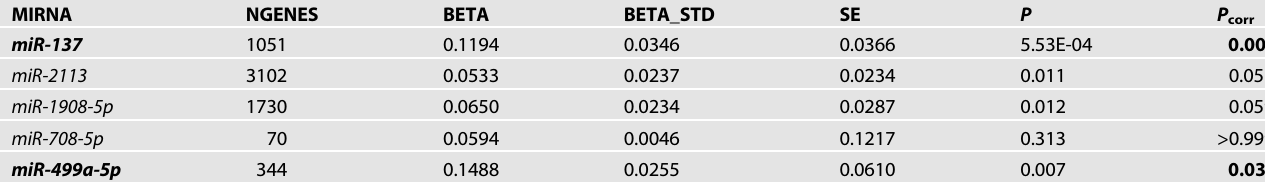
Table 2. Results of the gene-set analyses of brain-expressed target genes of the fi ve microRNAs. MIRNA NGENES